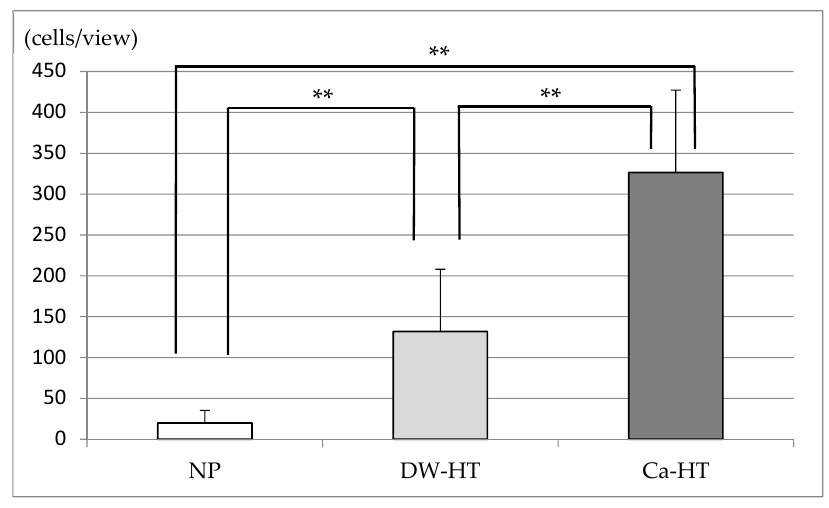
Figure 4. Adhesion of GE1 oral epithelial cells onto the substrata after 12 h of incubation. There were no significant di ff erences in the attached cell count among the three groups. ANOVA, analysis of variance. After 1 h of incubation of MC3T3-E1 osteoblastic cell line with the substrata, the attached cell count for the Ca-HT group was significantly higher than for the other two groups. The attached cell count for the DW-HT group was significantly higher than for the NP group (Figure 5). J. Clin. Med. 2020 , 9 , x FOR PEER REVIEW